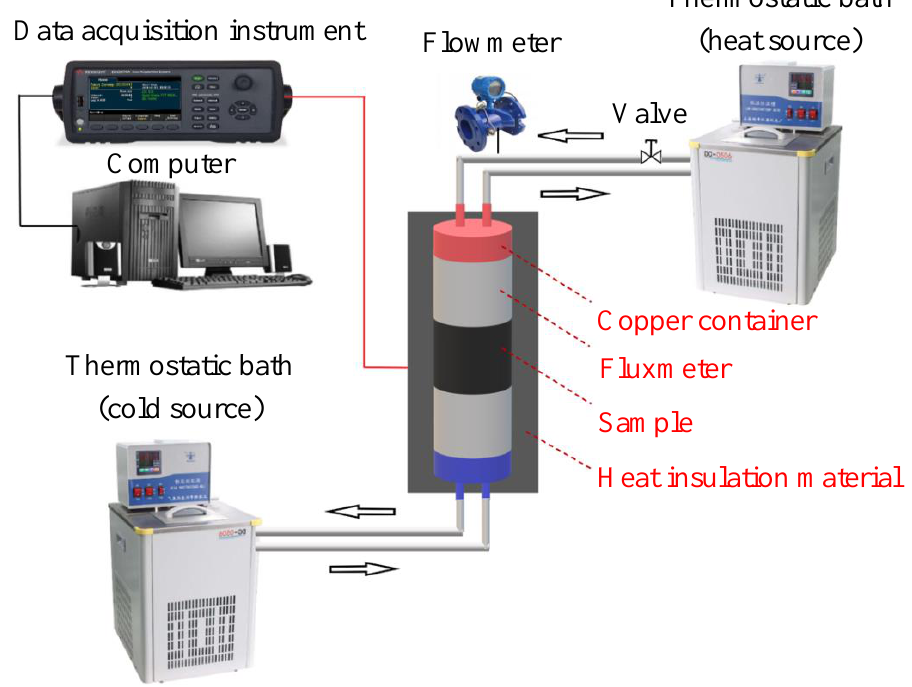
Figure 1. Schematic diagram of the experimental system.